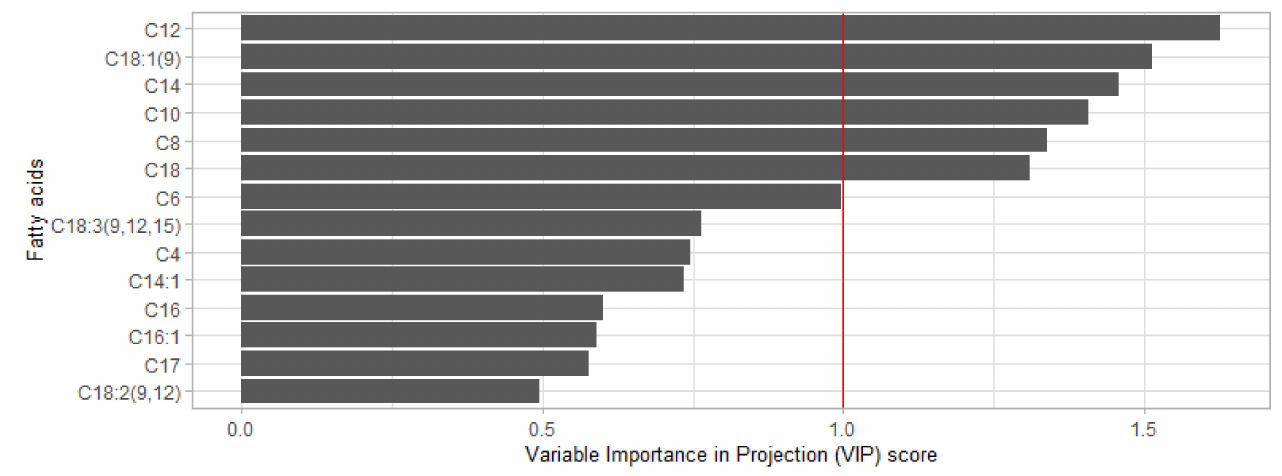
Figure 2. Scores for the variable importance of MIR fatty acids contents (g/100 g of fat) to predict dairy cows’ dry matter intake. Table 2. Cow-independent cross-validation and out-of-sample country-independent performance for partial least squares regressions predicting the dry matter intake (in kg) of dairy cows from datasets with different origins (AUS = Australia (number of records (N) = 5629), CAN = Canada (N = 4063), GPE = GplusE project (N =